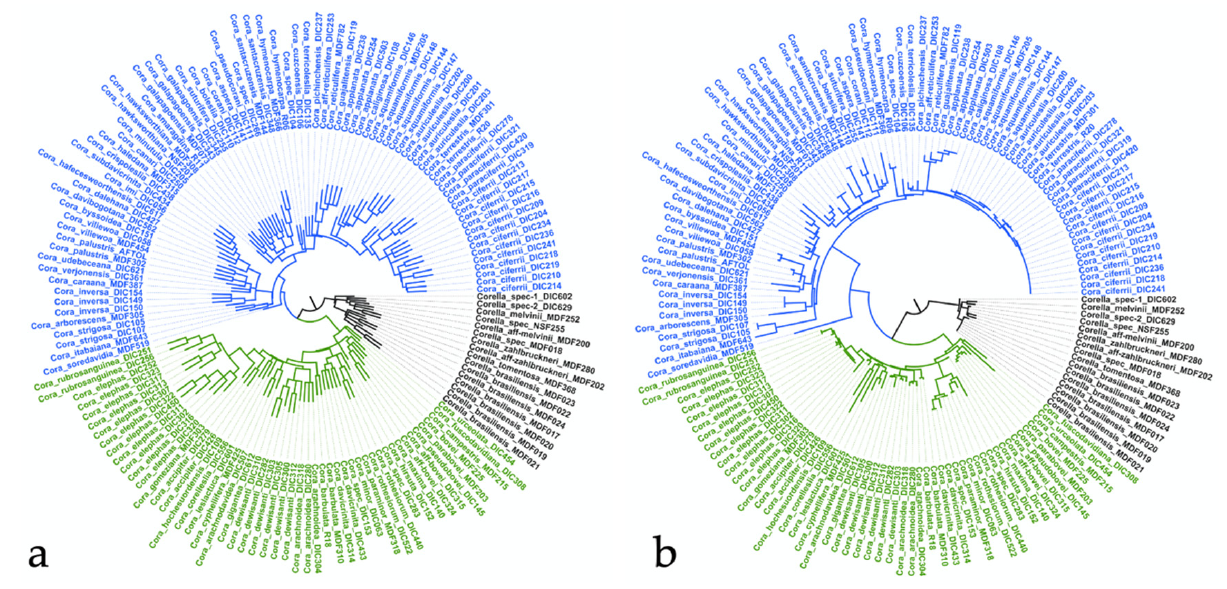
Figure 6. Comparison between inferred ASTRAL six ‐ marker species tree ( a ) and ITS maximum likelihood tree ( b ). The different colors simply denote the two major clades in Cora , with Corella in black as the outgroup.